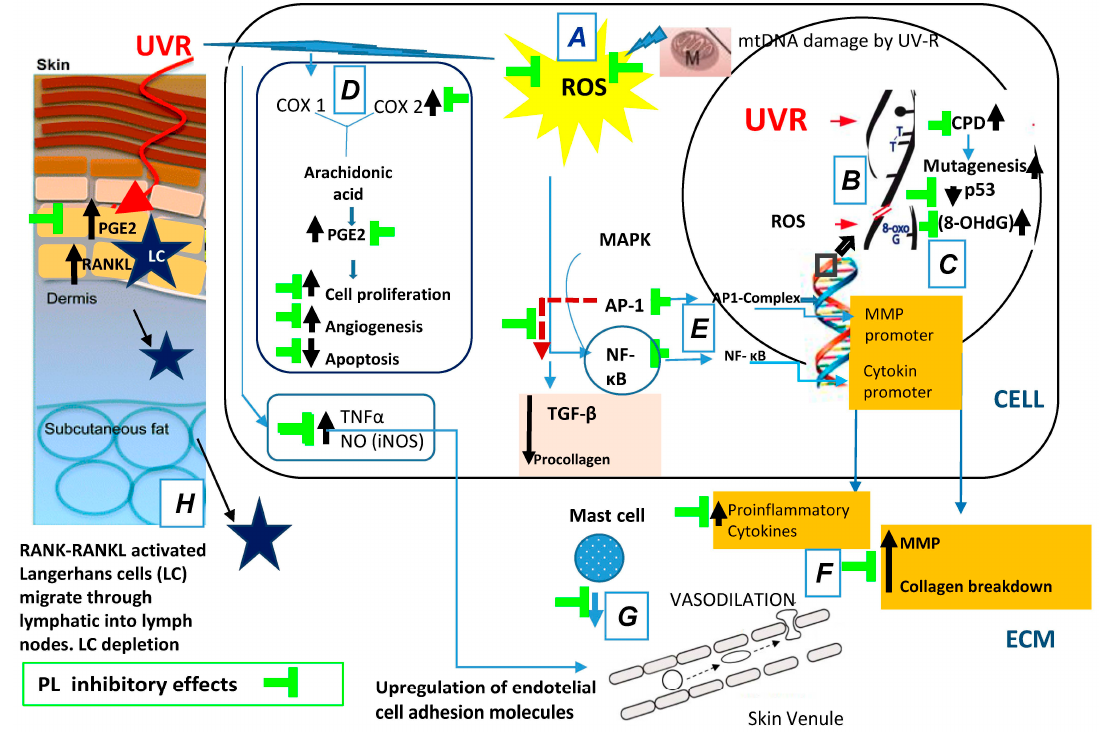
Figure 1. Polypodium leucotomos (PL) extract’s anti-UV effects: ( A ) decreases pro-inflammatory mechanisms of UV radiation include ROS-induced lipid peroxidation; ( B ) decreases UV-induced DNA damage; ( C ) increases the expression of active p53; ( D ) inhibits UV-induced Cox-2 enzyme levels; ( E ) reduces UV-induced nuclear transcription factors AP-1 and NF- κ B; ( F ) reduces MMPs production; ( G ) decreases inflammation and vasodilation; and ( H ) inhibits skin immunodepression. Black arrows indicate increased/decreased effects due to UVR. ROS, reactive oxygen species; mtDNA, mitochondrial DNA; UV, ultraviolet; ECM, extracellular matrix; CPD, cyclobutane pyrimidine dimers; MMP, matrix metalloproteinase; MAPK, mitogen-activated protein kinases; AP-1, activator protein-1; NF- κ B, nuclear factor kappa beta; TGF- β , transforming growth factor- β .; COX, cyclooxygenase enzymes; PGE2, prostaglandin E2; TNF- α , tumor necrosis factor- α ; iNOS, isoforms of nitric oxide synthase; RANK, receptor activator of nuclear factor kappa-B; RANKL, receptor activator of nuclear factor kappa-B ligand.